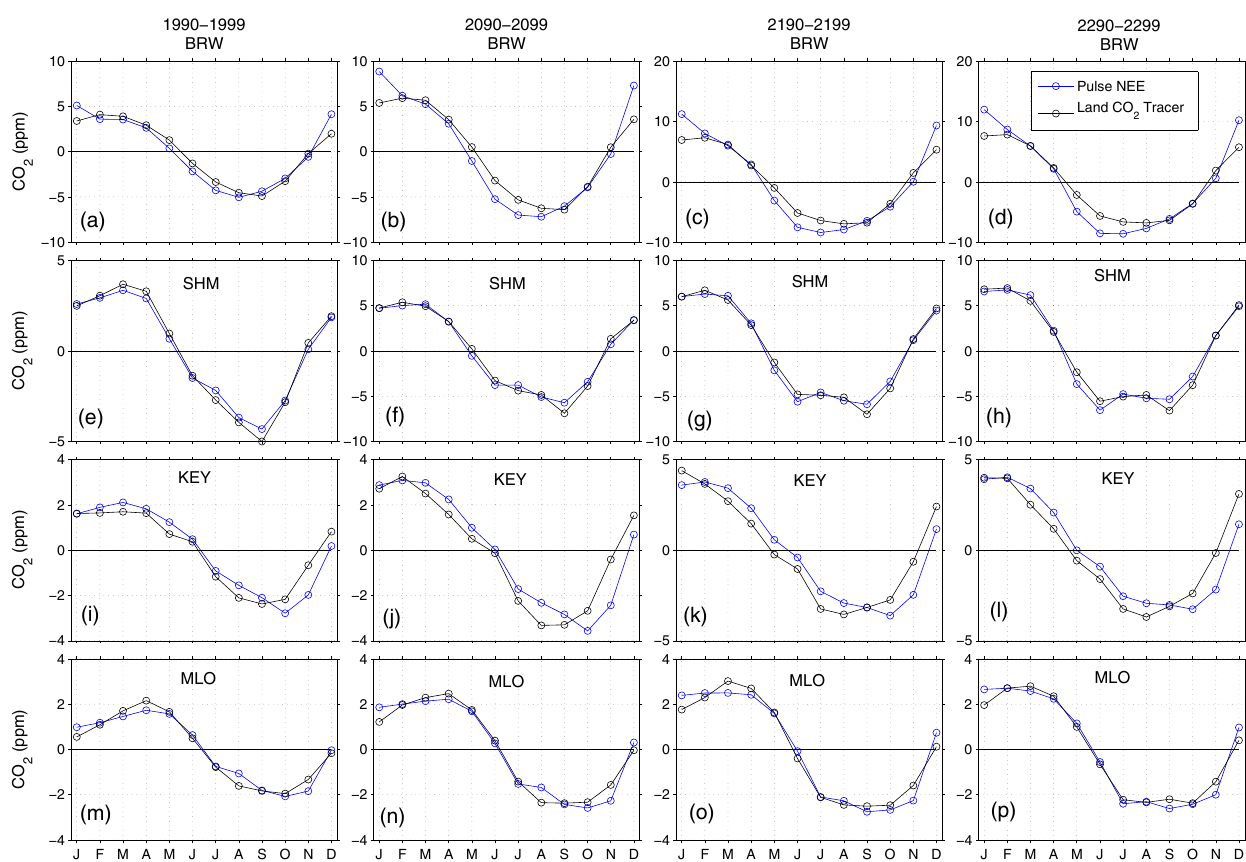
Figure 3. Mean annual cycles of atmospheric CO 2 derived from (blue curves) NEE run through the pulse-response function and (black curves) the CESM land CO 2 tracer for (a–d) Barrow (BRW), (e–h) Shemya Island (SHM), (i–l) Key Biscayne (KEY), and (m–p)